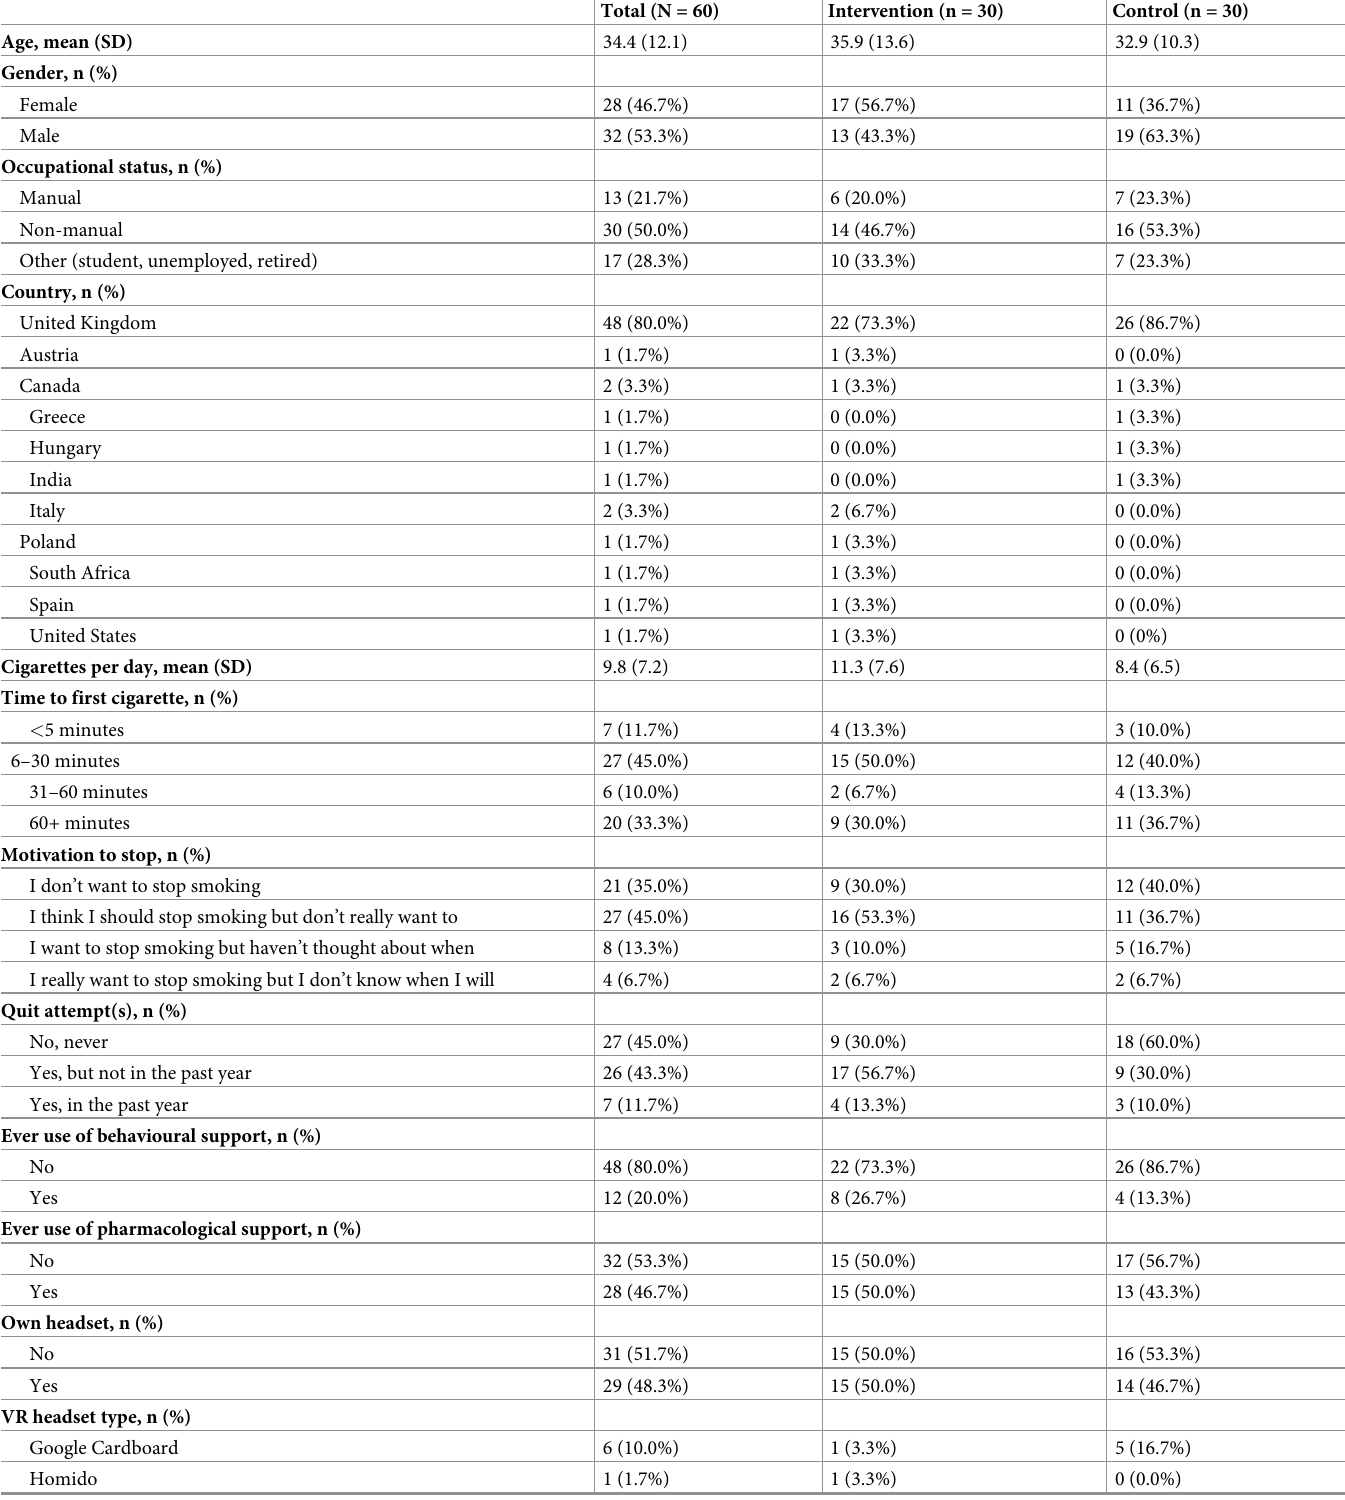
Table 1. Participant demographic and smoking characteristics (analytic sample, N =